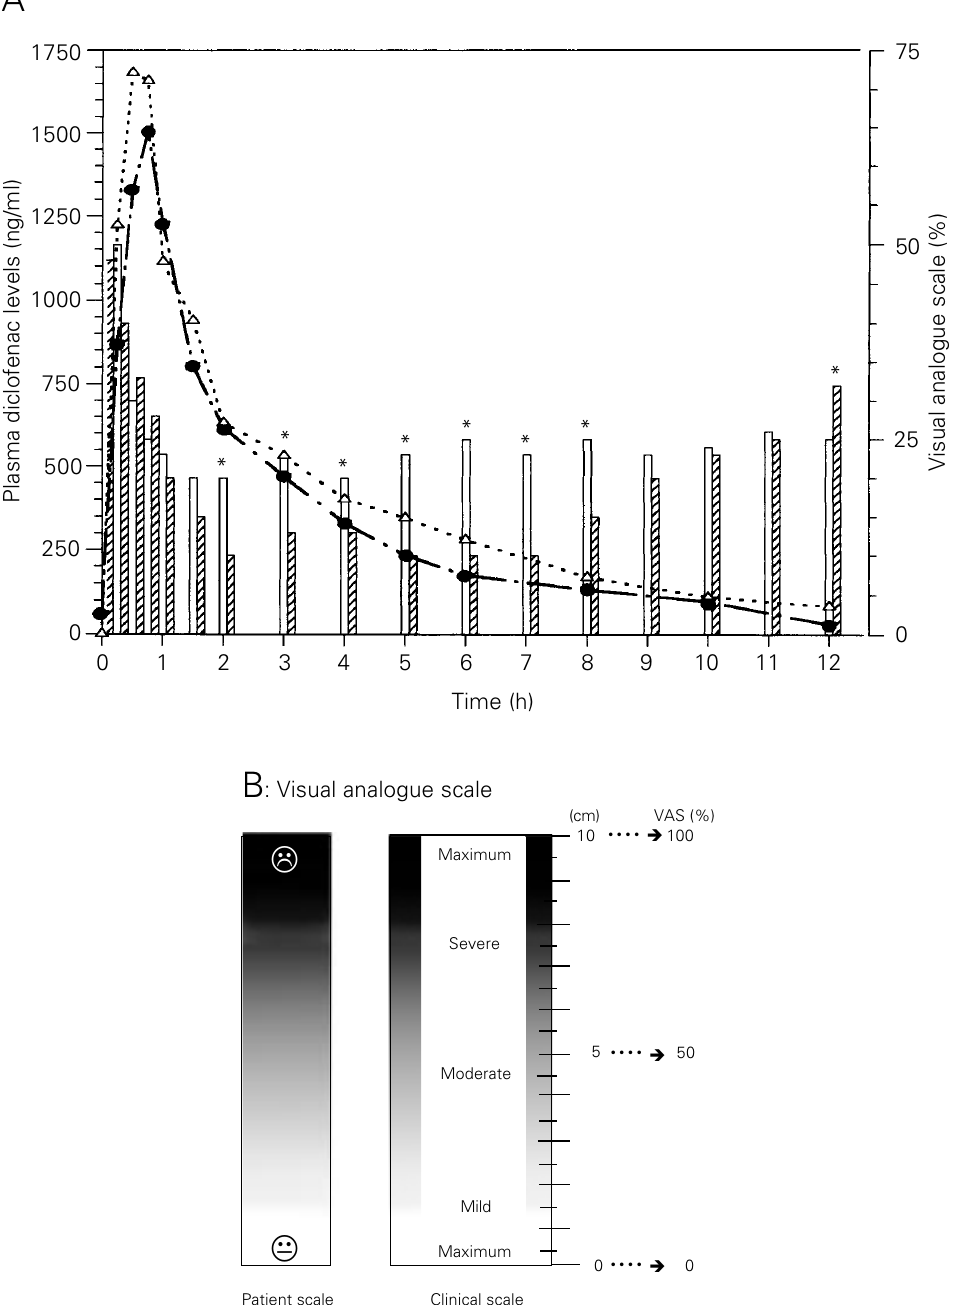
Figure 1 - Effect of cardiopulmonary bypass (CPB) on plasma diclofenac levels and analgesia. Patients received diclofenac (1 mg/kg, im ) after surgery. A , Left ordinate: D , plasma diclofenac levels of the CPB group (N = 10); • , plasma diclofenac levels of the control surgical group (N = 14). Right ordinate: analgesia measured with the visual analogue scale (see panel B for the explanation). , Pain level of the CPB group; 12 , pain level of the control surgical 12 group. *P<0.05 compared to control for analgesia (Wilcoxon test). All data are reported as median